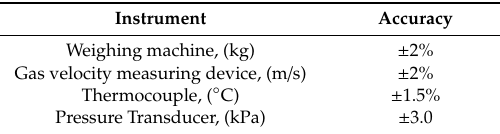
Table 4. The accuracy of the measuring